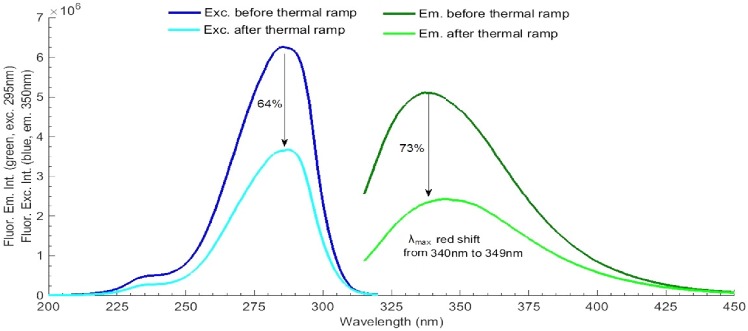
LYZ fluorescence excitation and emission spectra, before and after the thermal ramp at 45–90°C.Fluorescence excitation was fixed at 295 nm and fluorescence emission at 350 nm and excitation slit was set at 0.1 mm (0.1 μW).